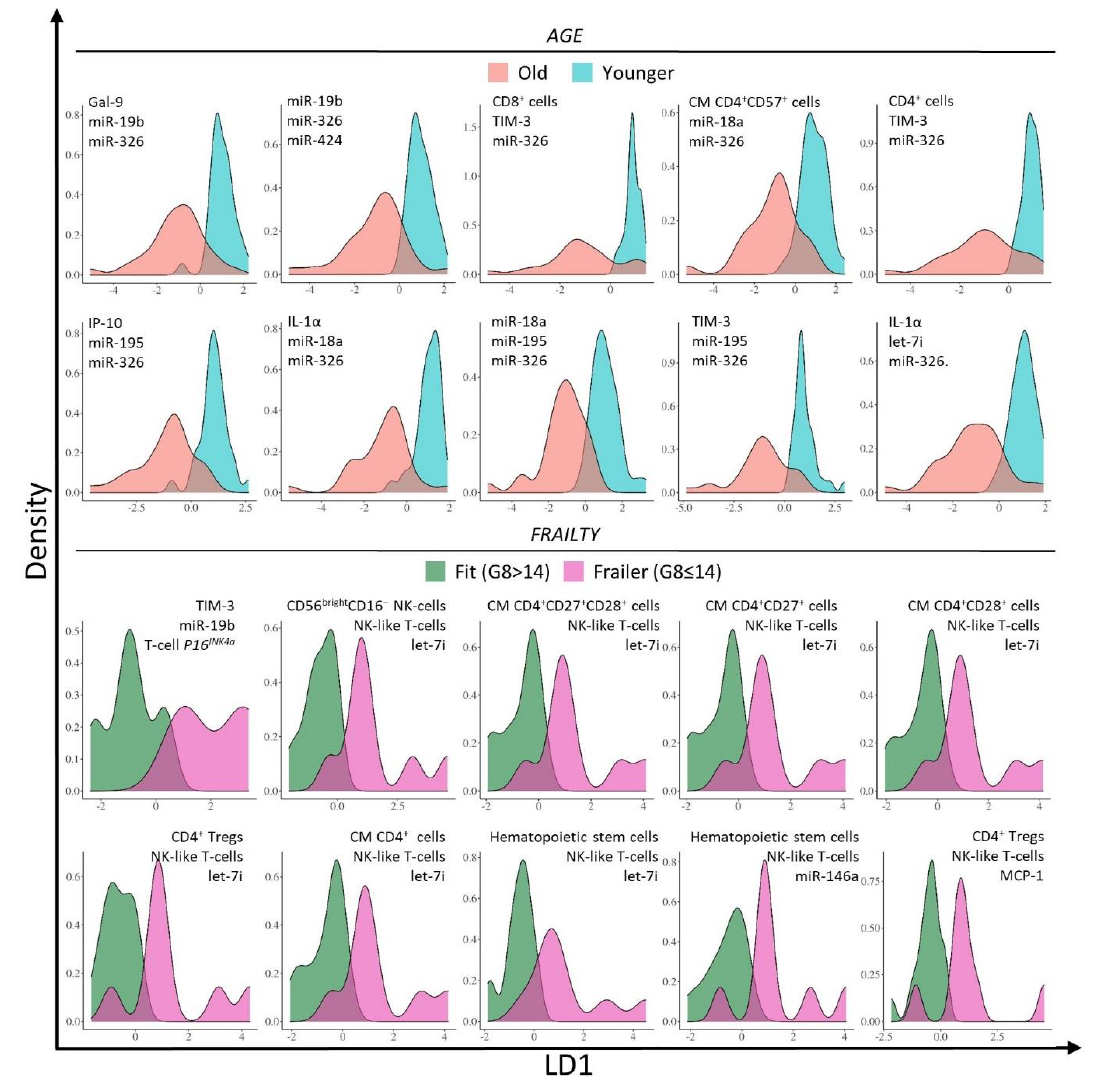
Figure 1. Linear discriminant analysis (LDA) density plots of the blood biomarker panels predicting age and frailty status with the LD1 coordinate on the x-axis and the density on the y-axis. The top 10 highest ranked blood biomarker panels are shown (Table 2). Old patients (≥70 years) are represented in blue, younger patients (35– 45/55 – 65 years) in red, fit patients (G8 > 14) in green and frailer patients (G8 ≤ 14) in purple.